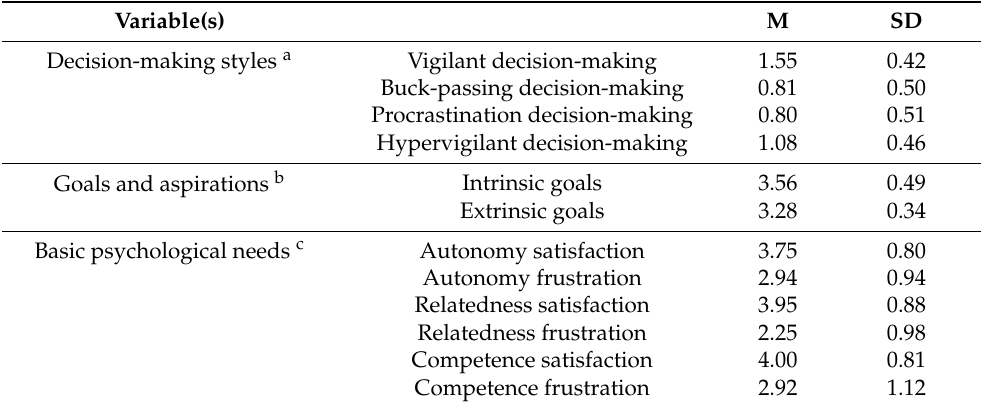
Table 2. Variable descriptive